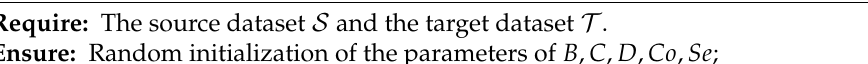
Algorithm 1 Proposed